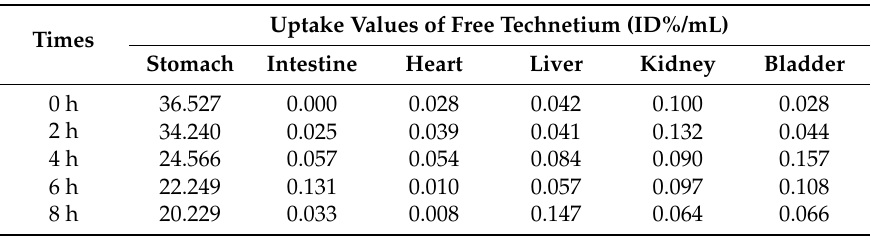
Table 5. Different organ uptake values of free technetium, taken orally, in rats ( n =